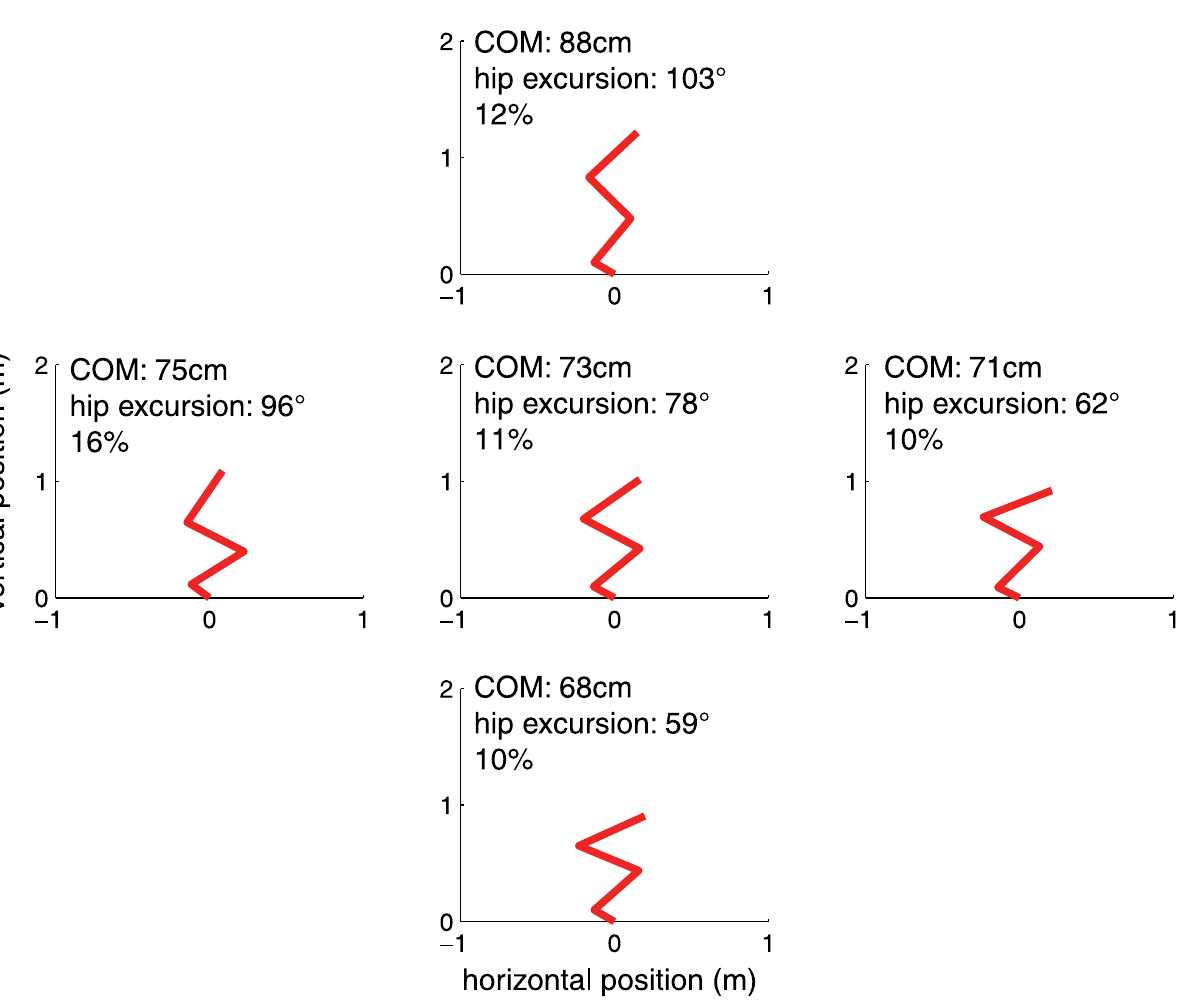
Fig 4. Jump performance from different initial positions. We examined the performance of the model, which was optimized for the center position, at four different initial configurations. The vertical positions vary in the initial center of mass, from 68 cm (bottom) to 88 cm (top). The horizontal positions vary in internal hip angle, from 62 to 96